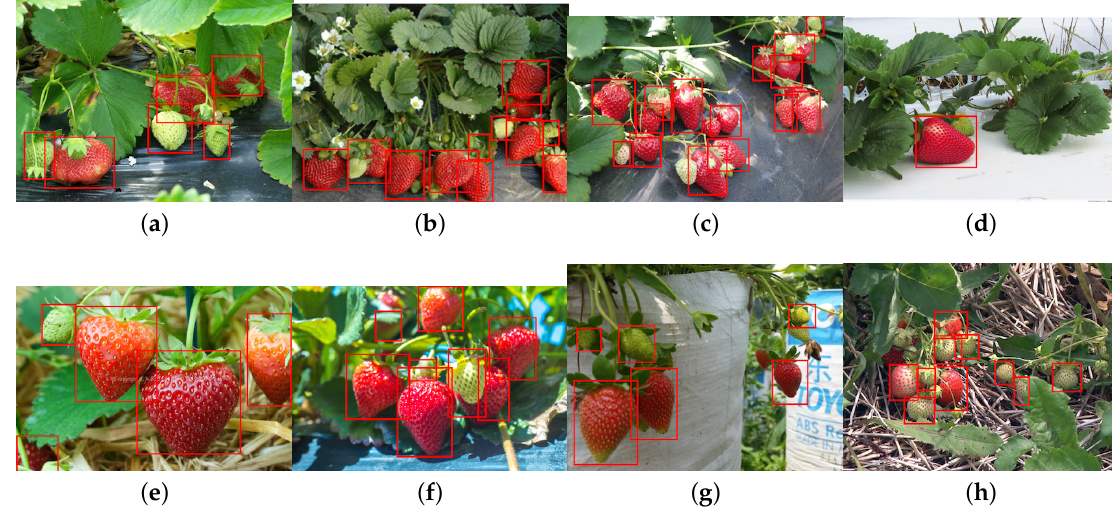
Figure 21. Eight instances ( a – g ), and ( h ) of strawberry detection (varying levels of ripeness). Images are obtained from Google